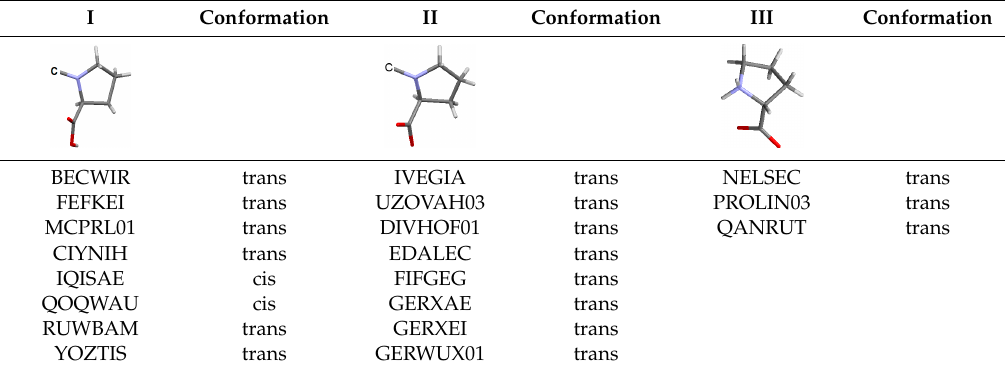
Table 1. Proline tectons in proline and ACEI structures as found in the CSD (three types of proline-based tectons, I, II, III are color-coded).